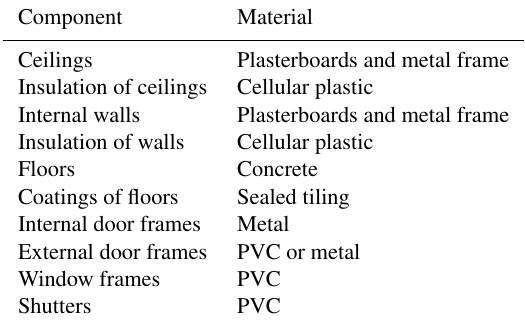
Table 1. Materials that limit the costs of repair or replacement after a